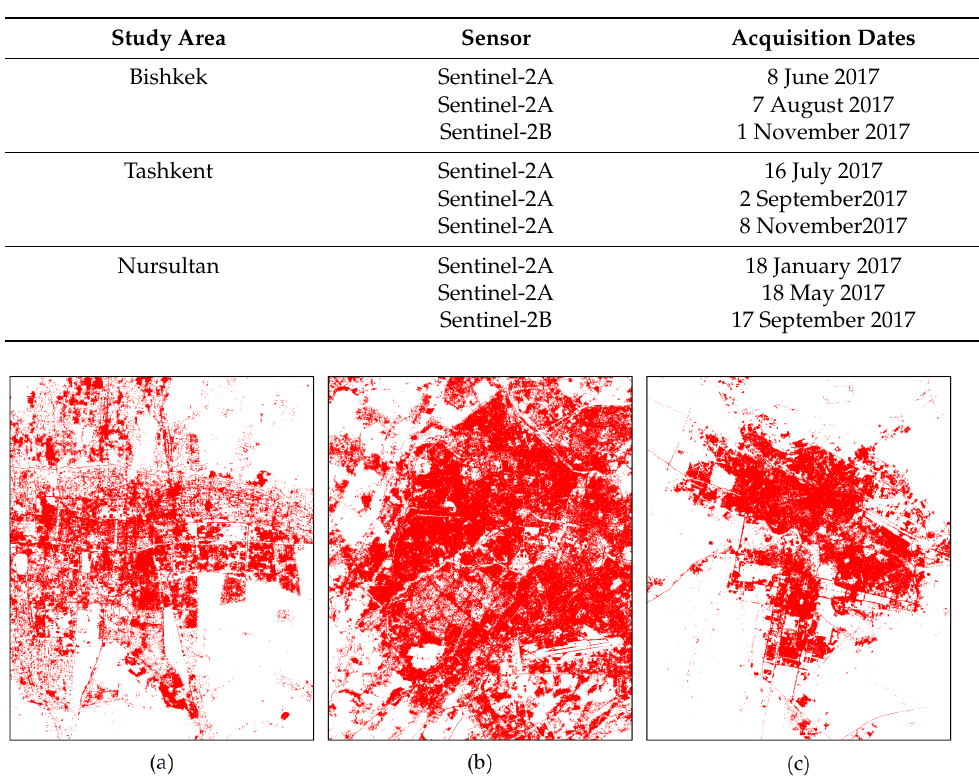
Table 4. Sentinel-2 data from three different periods in the study areas used for ISA extraction.